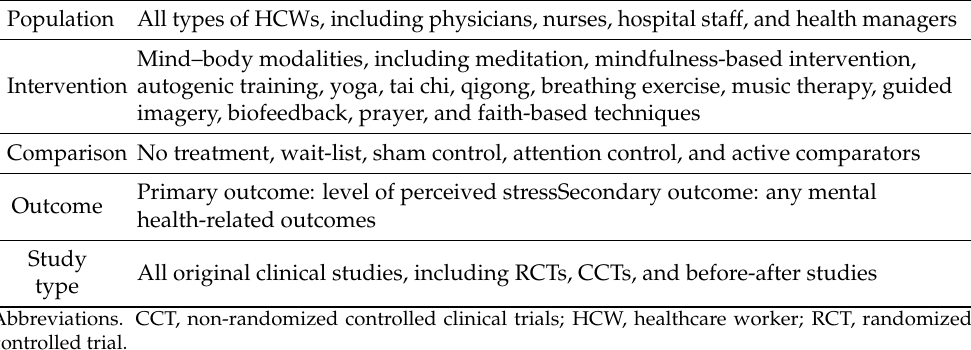
Table 2. The inclusion criteria of this review in PICOS format. Population All types of HCWs, including physicians, nurses, hospital staff, and health managers Mind–body modalities, including meditation, mindfulness-based intervention, Intervention autogenic training, yoga, tai chi, qigong, breathing exercise, music therapy, guided imagery, biofeedback, prayer, and faith-based techniques Comparison No treatment, wait-list, sham control, attention control, and active comparators Primary outcome: level of perceived stressSecondary outcome: any mental Outcome health-related outcomes Study All original clinical studies, including RCTs, CCTs, and before-after type